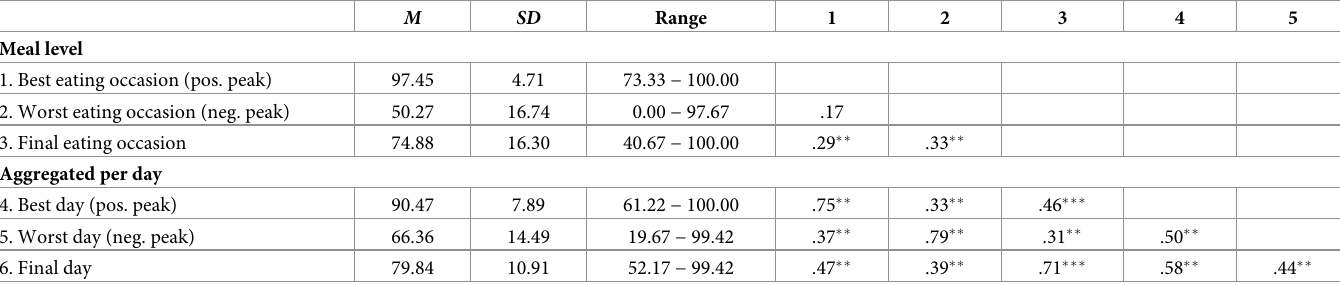
Table 1. Descriptive statistics and correlations of characteristics of in-the-moment experienced eating happiness on the meal level and aggregated per